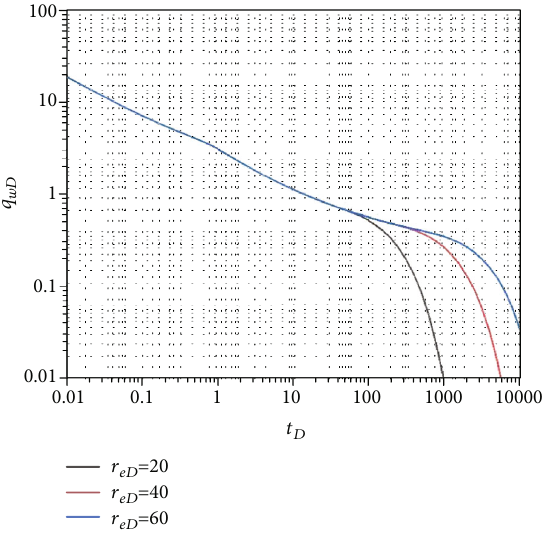
Figure 12: In fl uence of dimensional drainage radius on